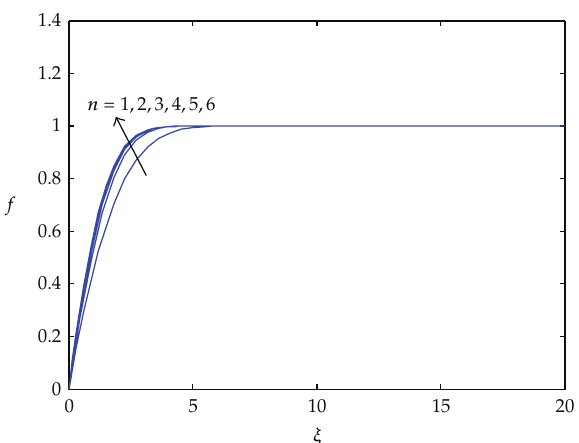
Figure 5: E ff ect of power index n on the similarity function f related to the x component of velocity (cid:7) ε 1 (cid:5) 1, ε 2 (cid:5) 1 (cid:8) .